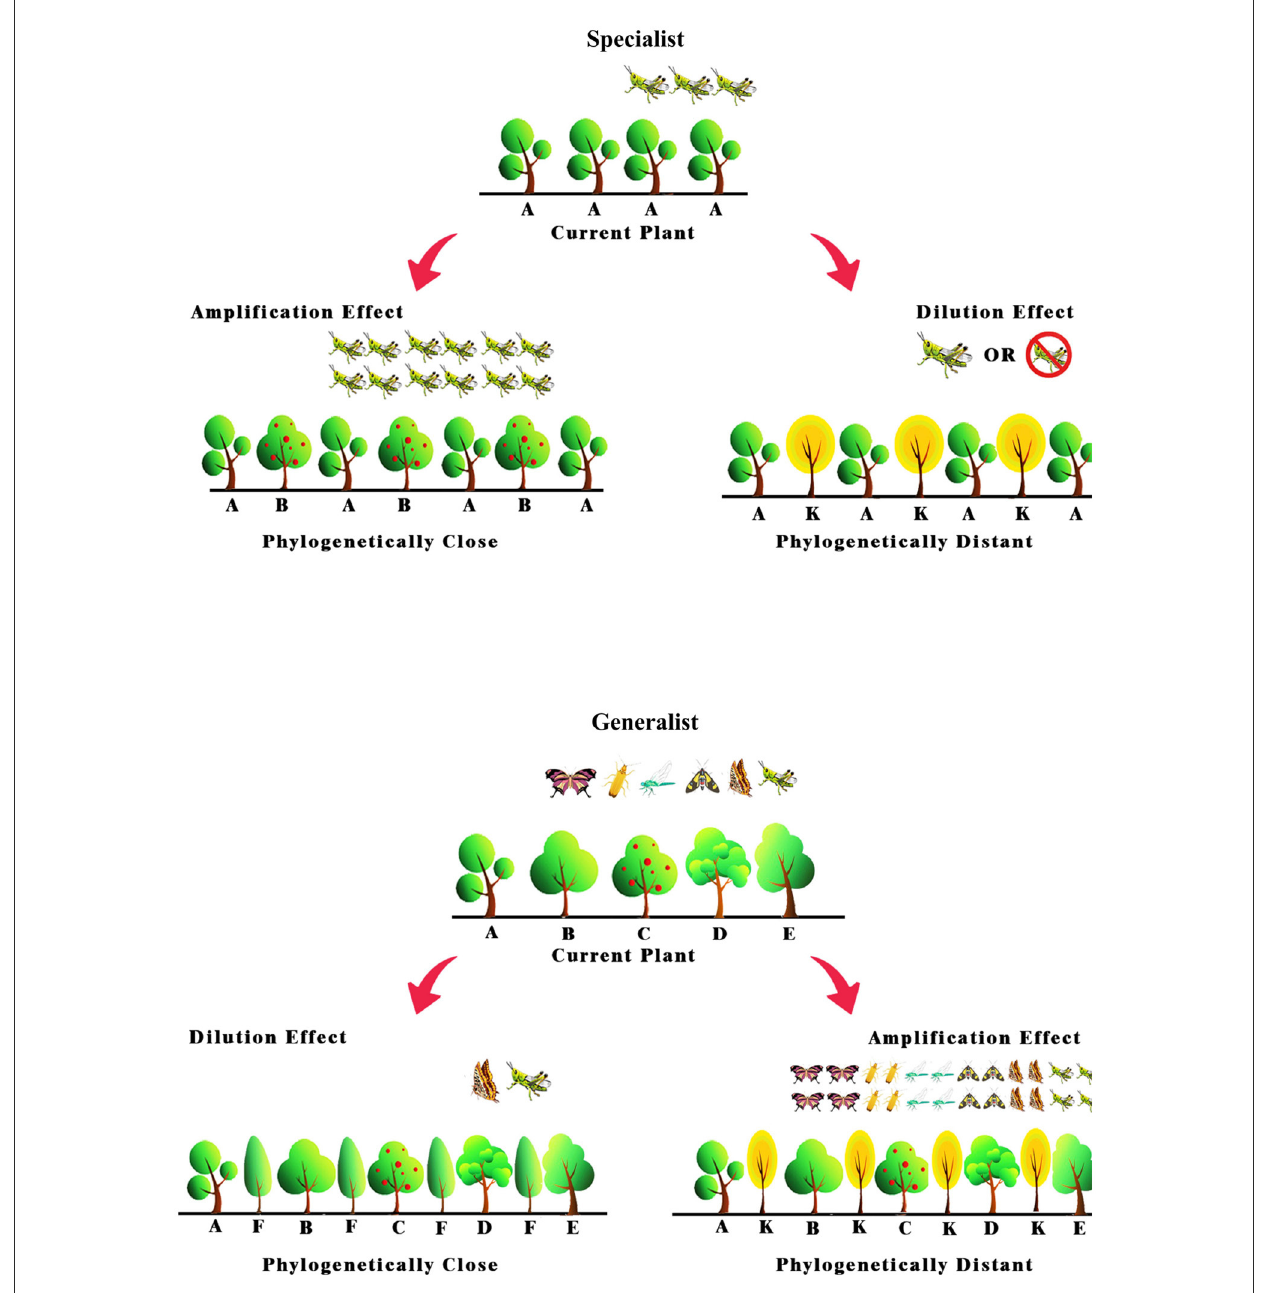
FIGURE1 Hypothesized dilute and amplified effects of mixing closely and distantly related tree species on specialist and generalist pest herbivory